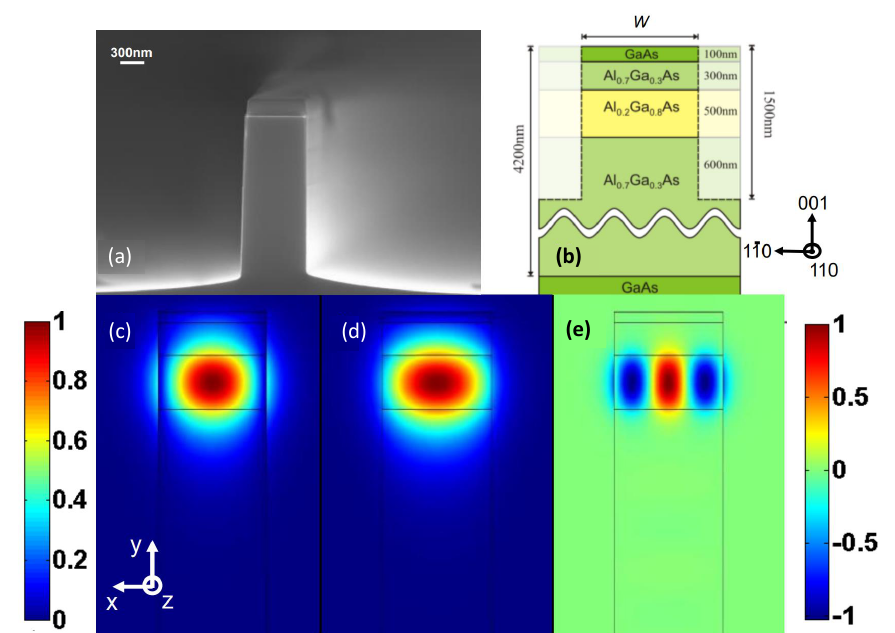
Figure 6. ( a ) Scanning electron microscopy image of an AlGaAs nanowire; ( b ) schematic of the corre- sponding waveguide geometry. ( c , d ) represent TE 00 and TM 00 modes at the fundamental wavelength λ 0 = 1582 nm, respectively; ( e ) represents the second-harmonic TE 02 mode at λ 0 = 791 nm. Adapted with permission from [115] ©The Optical Society.